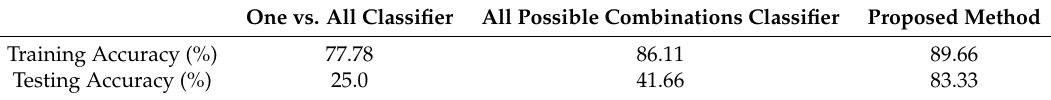
Figure 5. Proposed hierarchical structure for classifying 50 Hz power data. Table 9. Comparison of Different Classification Techniques for 50 Hz Audio